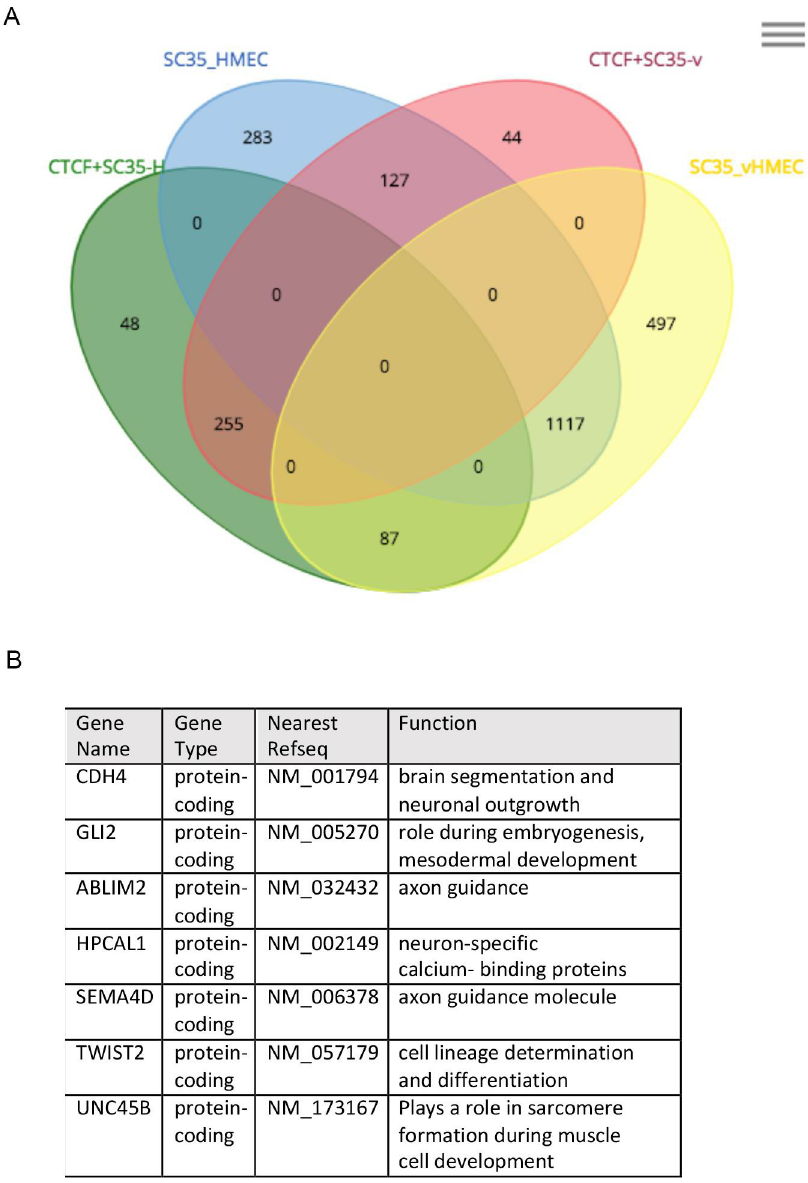
Fig 5. Stress-sensitive CTCF-RNA interactions that are shared with SC35. (A) Venn diagram showing the number of unique RNAs interacting with CTCF and/or SC-35 in HMECs compared to vHMECs, based on RIP-seq data. (B) List of top CTCF interactions with RNA in HMECs that were lost in vHMECs, but still remained bound to SC-35.